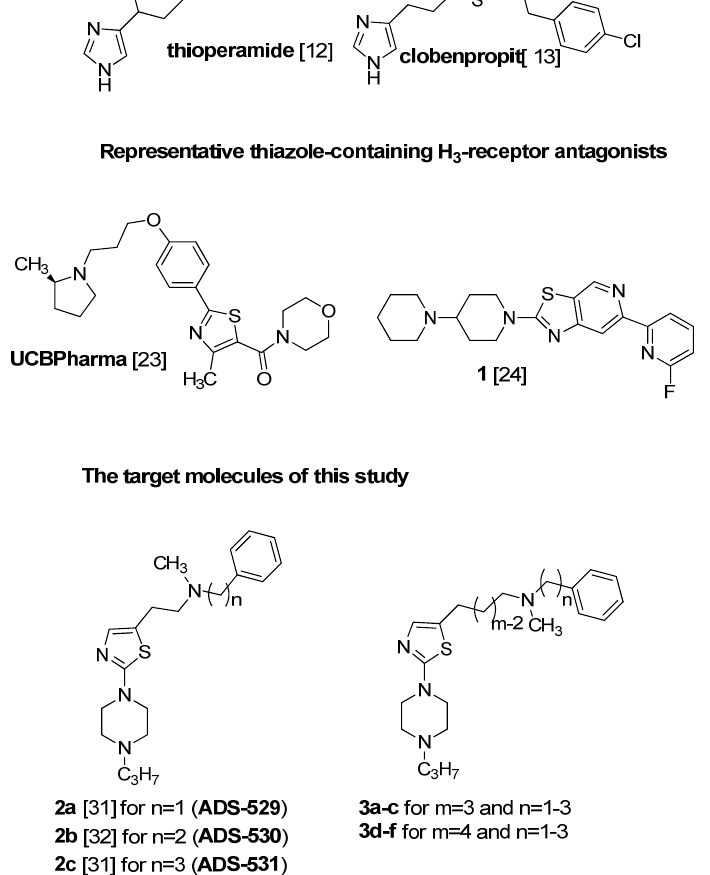
Figure 1. Structures of some known histamine H 3 -receptor antagonists and the target molecules of this study.